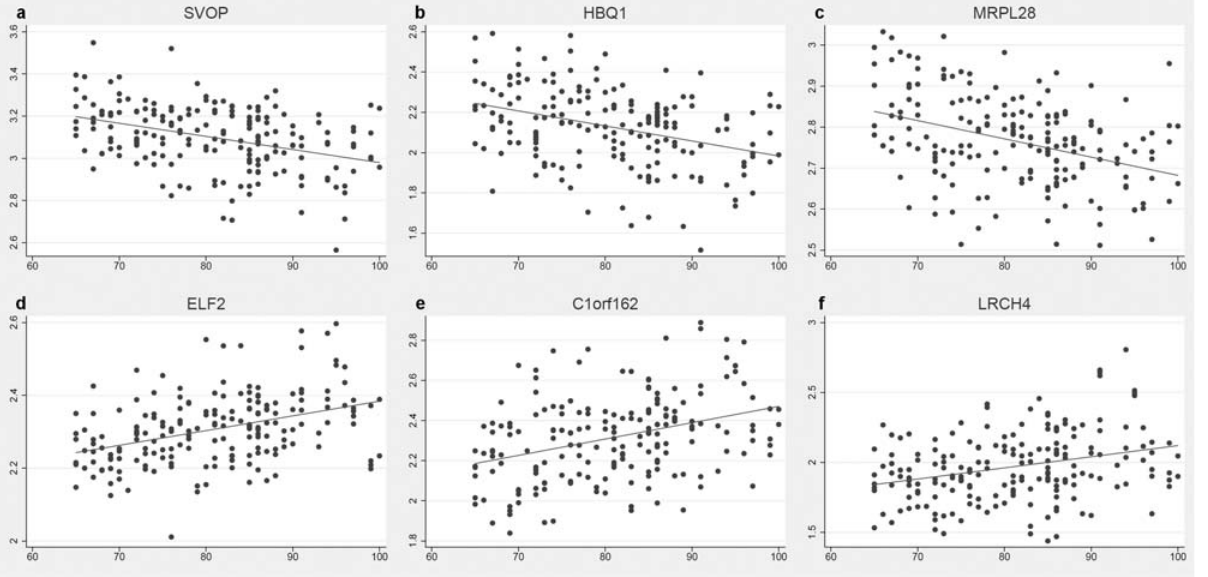
Figure 1. Scatter plots and fitted linear regression lines of the most significantly associated down-regulated (a–c) and up-regulated (d–f) genes with age-at-death in brain samples. doi:10.1371/journal.pone.0003024.g001 PLoS ONE |